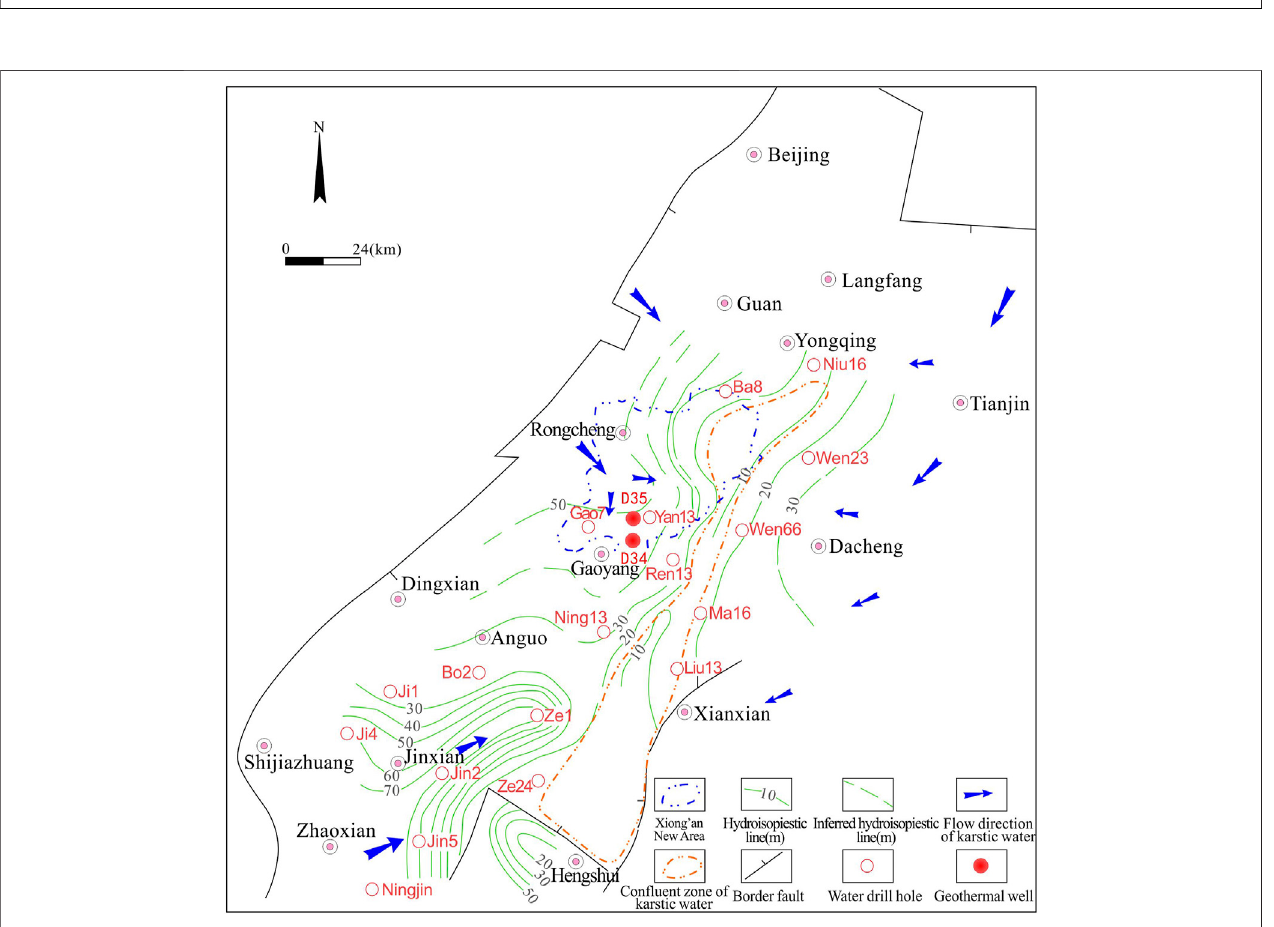
FIGURE 10 | Contour map of the phreatic pressure level elevation in the Jizhong depression (according to Yan and Yu, 2000).